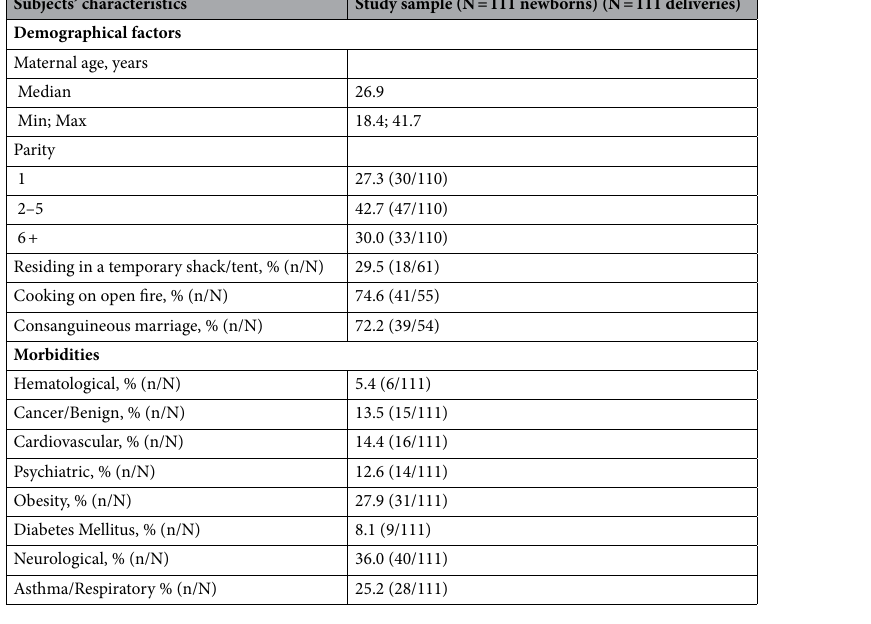
Table 1. Demographic characteristics of the study